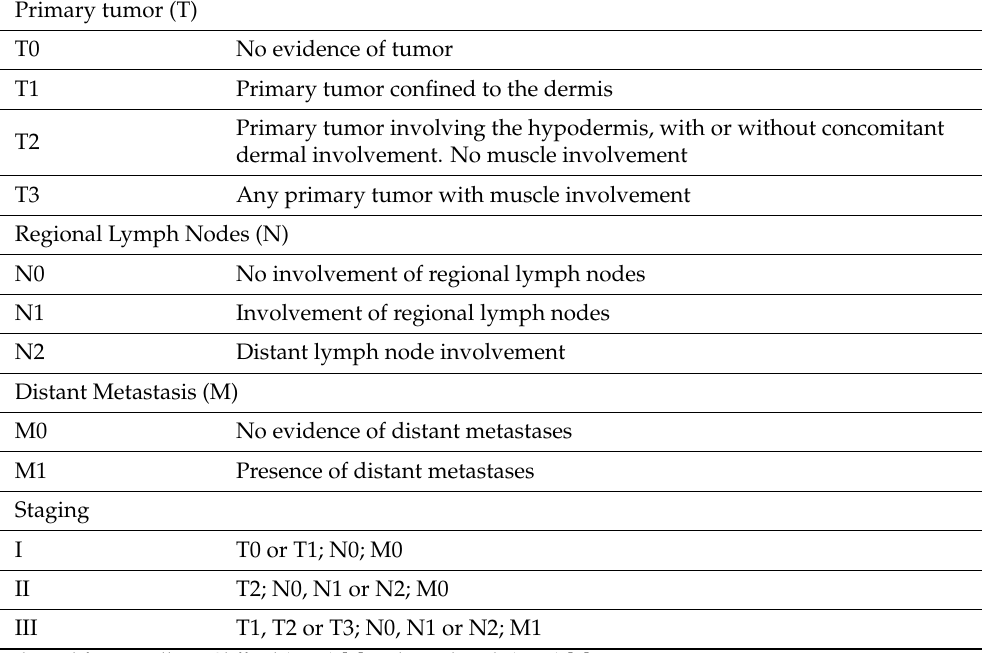
Table 1. Proposed clinical staging model for canine cutaneous